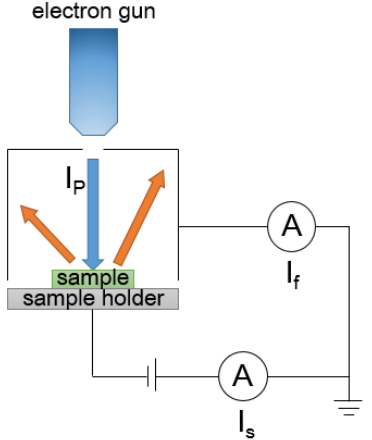
Figure 1. Schematic diagram of secondary electron yield test.